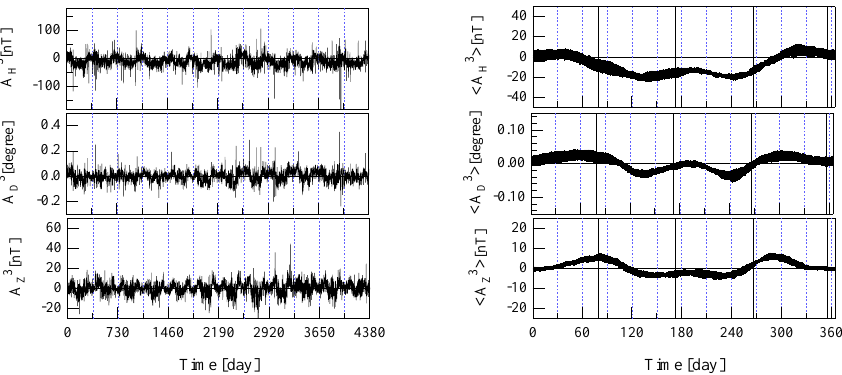
Fig. 9. The PCs associated with the EOFs reported in Fig. 8 for H, D and Z magnetic field elements (left panels) and the average annual behavior of PCs as evaluated applying the superposed epoch analysis (right panels). The vertical solid lines in right panels indicate the equinoxes and solstices.